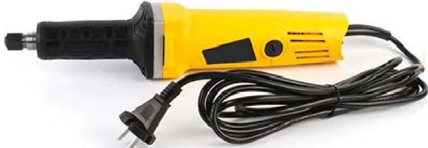
Figure 5: Electric grinding